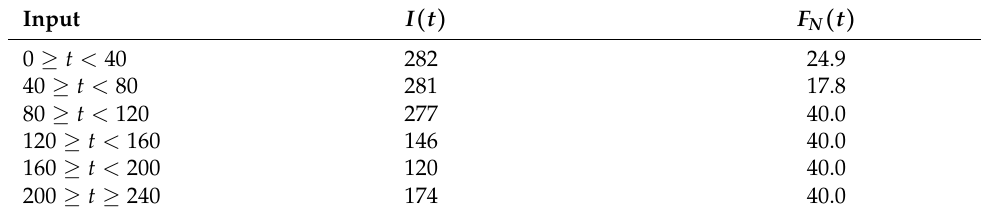
Table A4. Plant optimum